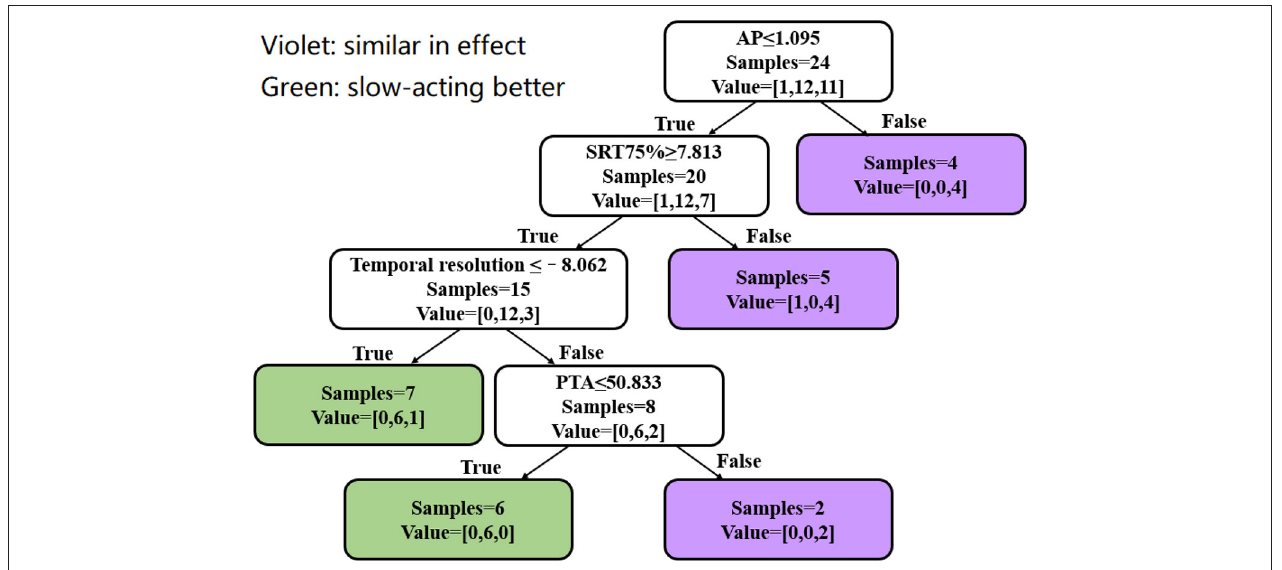
FIGURE 7 | Decision tree analysis. Violet represents a similar aided SRT75% between the two compression speeds. Green represents better SRT75% for SAC than FAC. Value = [A, B, C]: A is the number of subjects who performed better with FAC, B is the number of subjects who performed better with SAC, and C is the number of subjects where performance between FAC and SAC was similar.